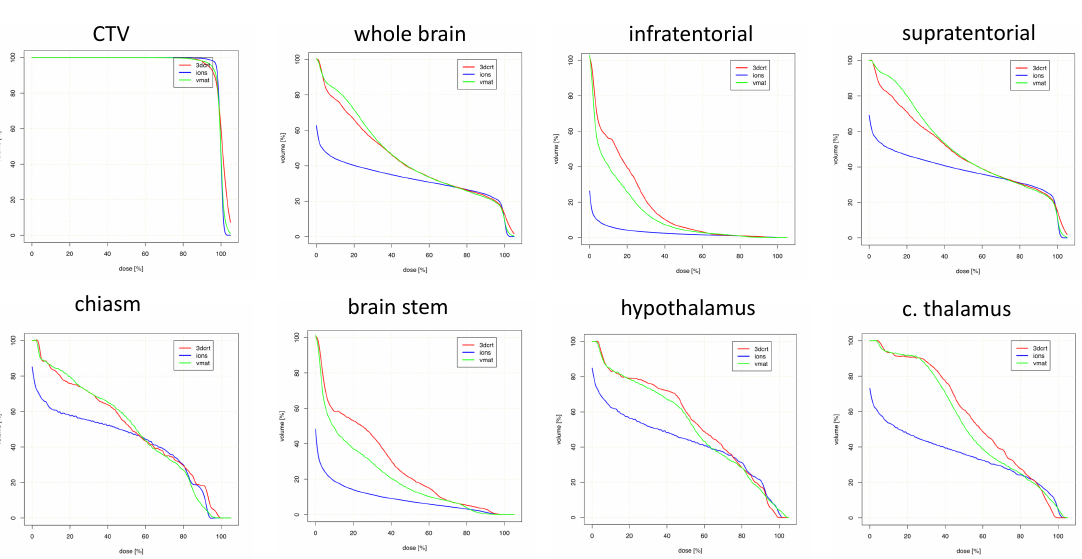
Figure 1. Dosimetric comparison: clinical target volume coverage and dose volume histogram curves of the organs-at-risk in patients with frontal tumor localization. Curves demonstrate median dose values of all patients with frontal tumor localization. Intensity-modulated proton therapy (IMPT/PRT; blue line) vs. volumetric-modulated arc therapy (VMAT; green line) vs. three-dimensional conformal radiotherapy (3DCRT; red line). CTV: clinical target volume; c.: contralateral.